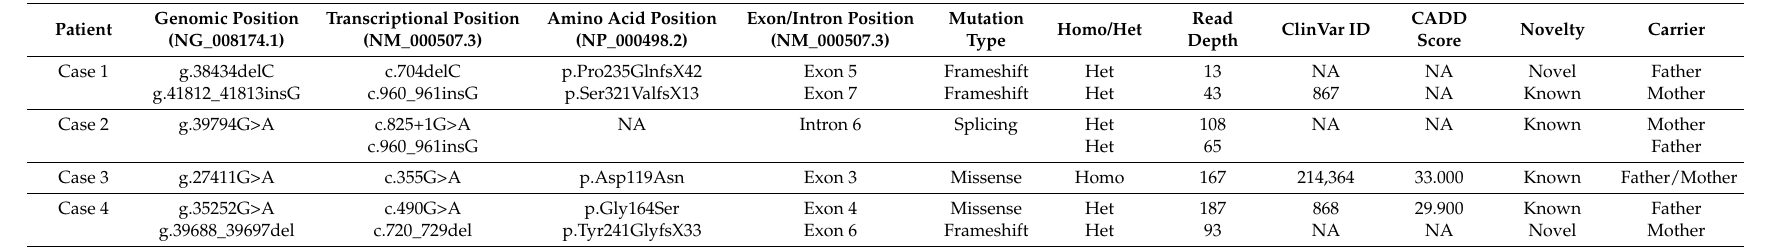
Table 2. Annotations of the identified variations in FBP1